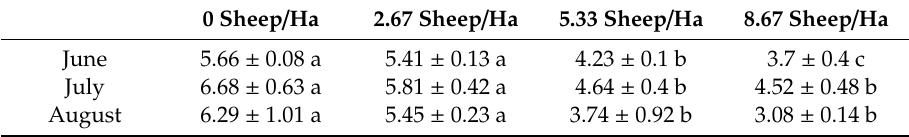
Table 4. Soil moisture (0–10 cm) under four stocking rates.